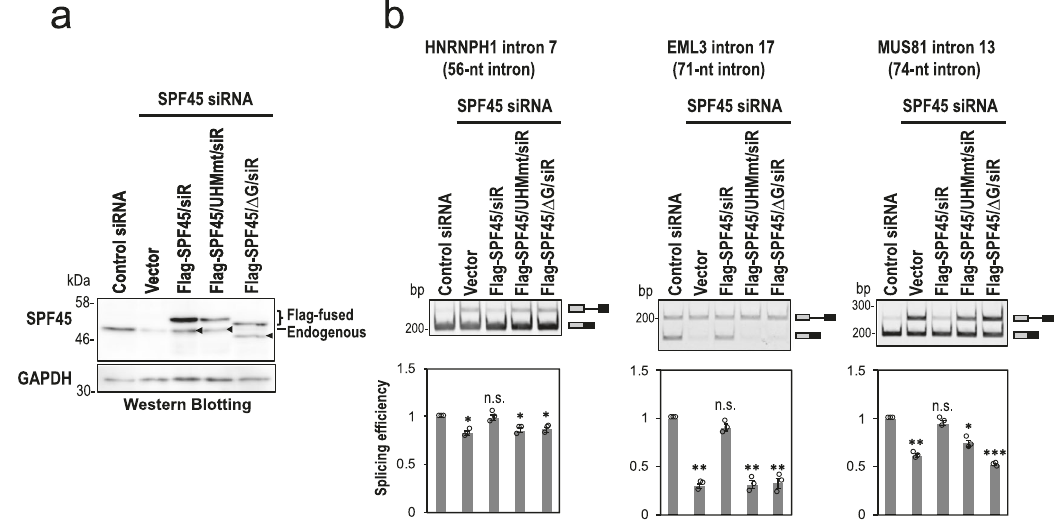
Fig. 8 The expression of siRNA-resistant SPF45 proteins rescue splicing of short introns in SPF45-depleted cells. a The expressed Flag-fused siRNA- resistant (siR) proteins and endogenous SPF45 in HeLa cells were checked by Western blotting. Displayed blots are representative of three independent experiments. Arrowheads indicate degraded siRNA-resistant (siR) proteins, but not endogenous SPF45 (see ‘ vector ’ lane for the depletion ef fi ciency of endogenous SPF45). b After the co-transfection of the indicated siRNA-resistant plasmids and three mini-gene plasmids, splicing ef fi ciencies of the indicated three mini genes were analyzed by RT-PCR. Means ± SEM are given for three independent experiments and two-tailed Student t -test values were calculated (HNRNPH1 intron: p = 0.0175 for Control vs Vector, p = 0.8177 for Control vs Flag-SPF45/siR, p = 0.0270 for Control vs Flag-SPF45/UHMmt/ siR, p = 0.0250 for Control vs Flag-SPF45/ Δ G/siR; EML3 intron: p = 0.0012 for Control vs Vector, p = 0.1085 for Control vs Flag-SPF45/siR, p = 0.0035 for Control vs Flag-SPF45/UHMmt/siR, p = 0.0057 for Control vs Flag-SPF45/ Δ G/siR; MUS81 intron: p = 0.0020 for Control vs Vector, p = 0.1693 for Control vs Flag-SPF45/siR, p = 0.0177 for Control vs Flag-SPF45/UHMmt/siR, p = 0.0004 for Control vs Flag-SPF45/ Δ G/siR). * P < 0.05, ** P < 0.01, *** P < 0.001, n.s. P > 0.05. Source data of all the above panels are provided as a Source Data fi